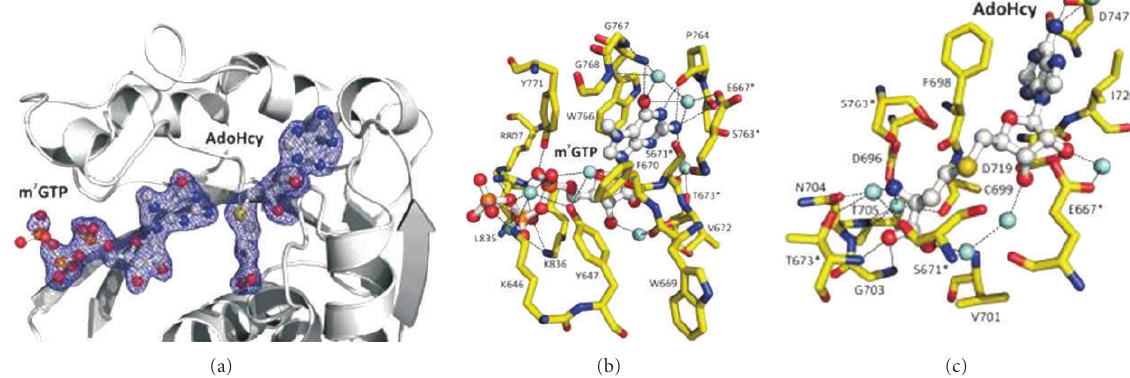
Figure 34: Crystal structure of hTgs1 [90]. The crystal structure of hTgs1 with substrate m 7 GTP and AdoHcy (at the site for AdoMet). The m 7 G is stacked between tryptophan 766 and serine 671 [90]. (a) Relative orientation of substrates m 7 GTP and AdoHcy at binding pockets. (b) Detailed view of the binding pocket for m 7 GTP (shown W766 and S671). (c) Detailed view of the binding pocket for AdoHcy.